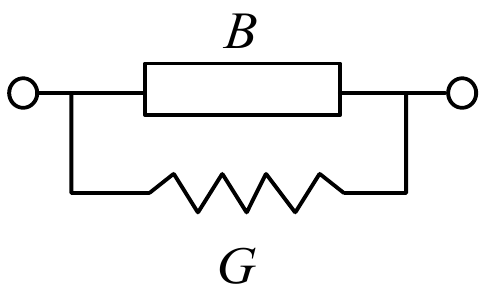
Figure 4. The equivalent circuit of the centred slot on the top surface of SIW.